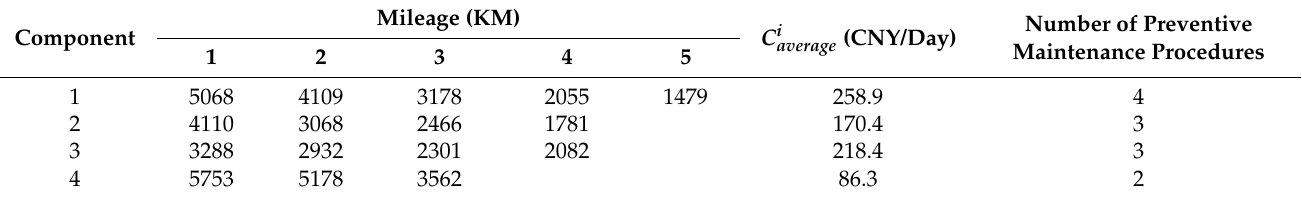
Table 5. Preventive maintenance interval of each component (mileage).